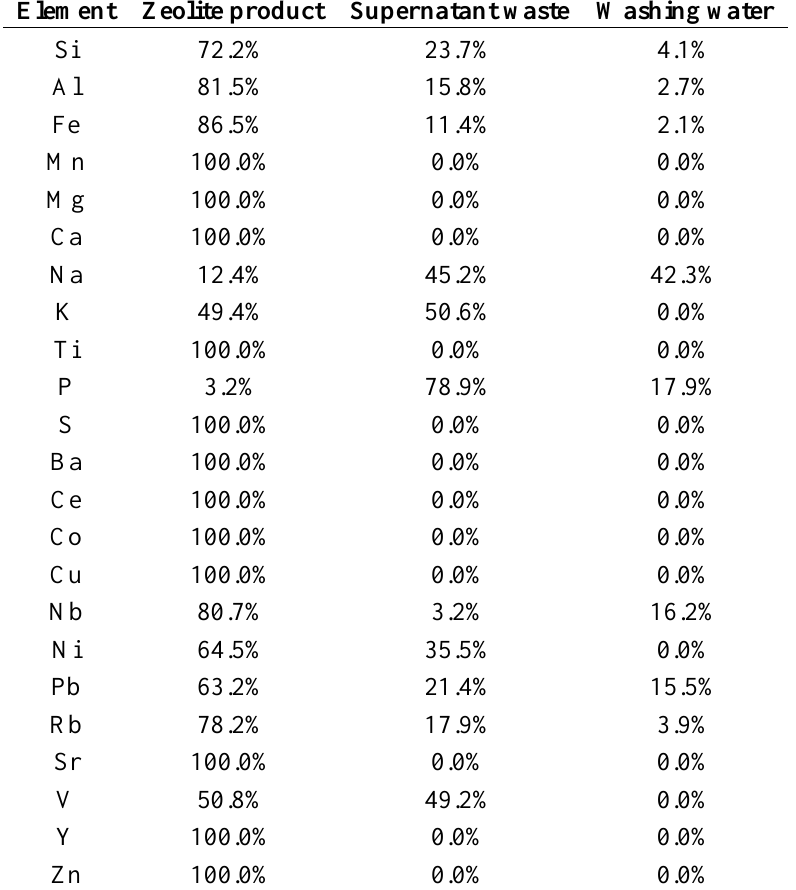
Table 2. Elemental balance illustrating the distribution of the elements (wt%) originating from fly ash amongst the different products resulting from the 2-step synthesis